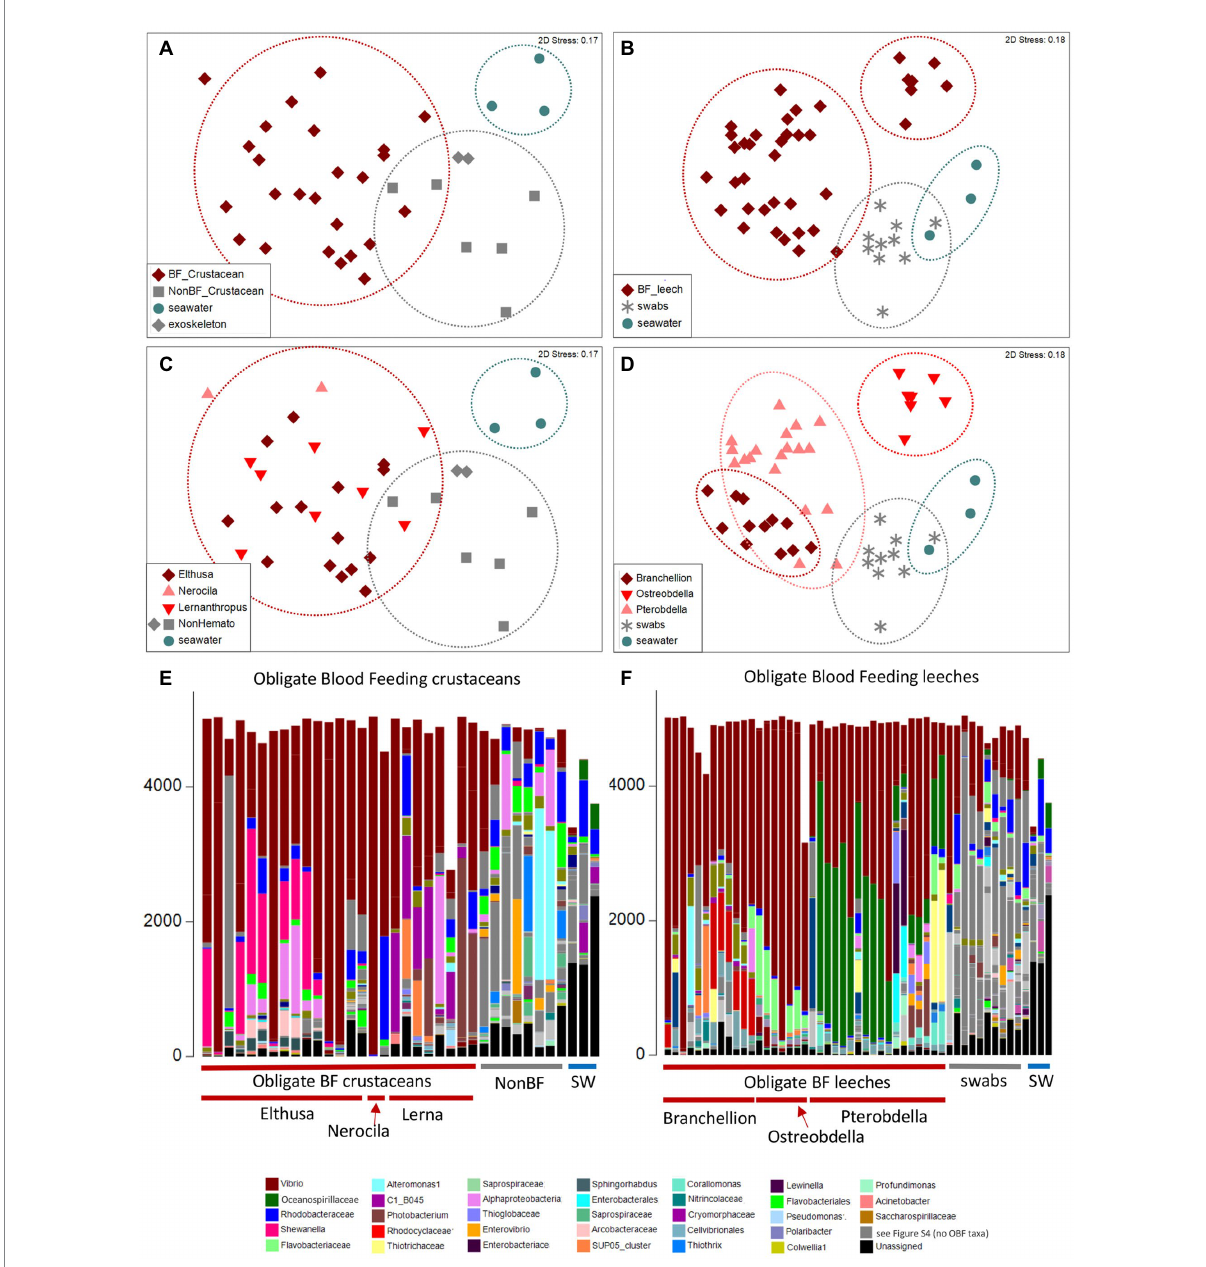
FIGURE 2 Microbiome diversity analysis of obligate blood feeding (OBF) crustaceans and leeches, based on 16S rRNA gene sequence similarity, using Non- metric multidimensional scaling (NMDS) ordination plots based on Bray–Curtis similarity resemblance, at the (A,B) broad category level, including blood-feeding versus comparison samples of non-blood feeding (NonBF) taxa, biological surfaces, and seawater (SW) and at the (C,D) specific blood-feeding taxa level. (E,F) Relative abundance of bacterial community structure at the genus level, from marine blood-feeders collected primarily from southern California coastal waters, including isopods Elthusa and Nerocila , the copepod Lernanthropus (Lerna), and leeches Branchellion, Ostreobdella, and Pterobdella (specific specimens are listed in Supplementary Table S1 in the same order as shown in the bar charts). Assigned bacterial taxa are color-coded as shown below. Taxa in dark gray were only found in the non-blood feeder (NBF) or seawater (SW) samples. Taxa in light gray were minor taxa in all specimens. See Supplementary Table S4 for a full